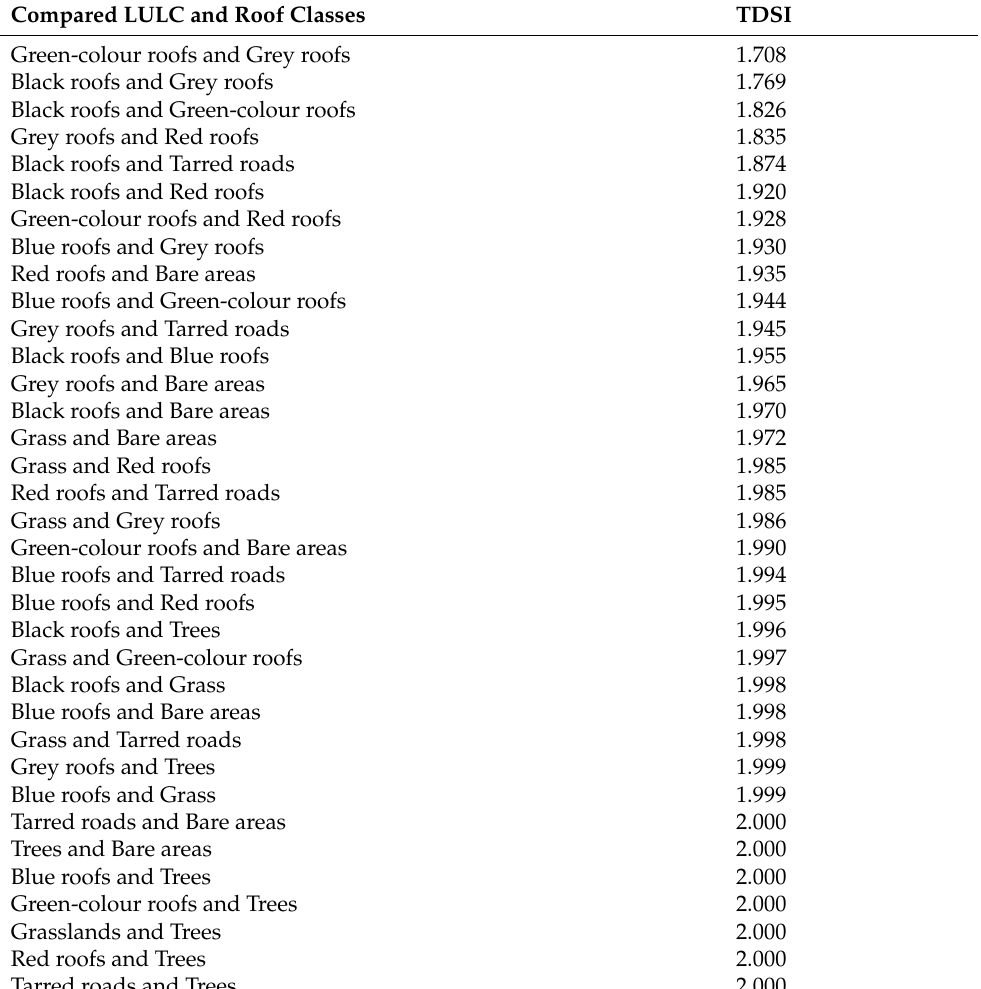
Table 1. Discriminability of LULC types in the study area using 10-m resolution Sentinel 2 data. Compared LULC and Roof